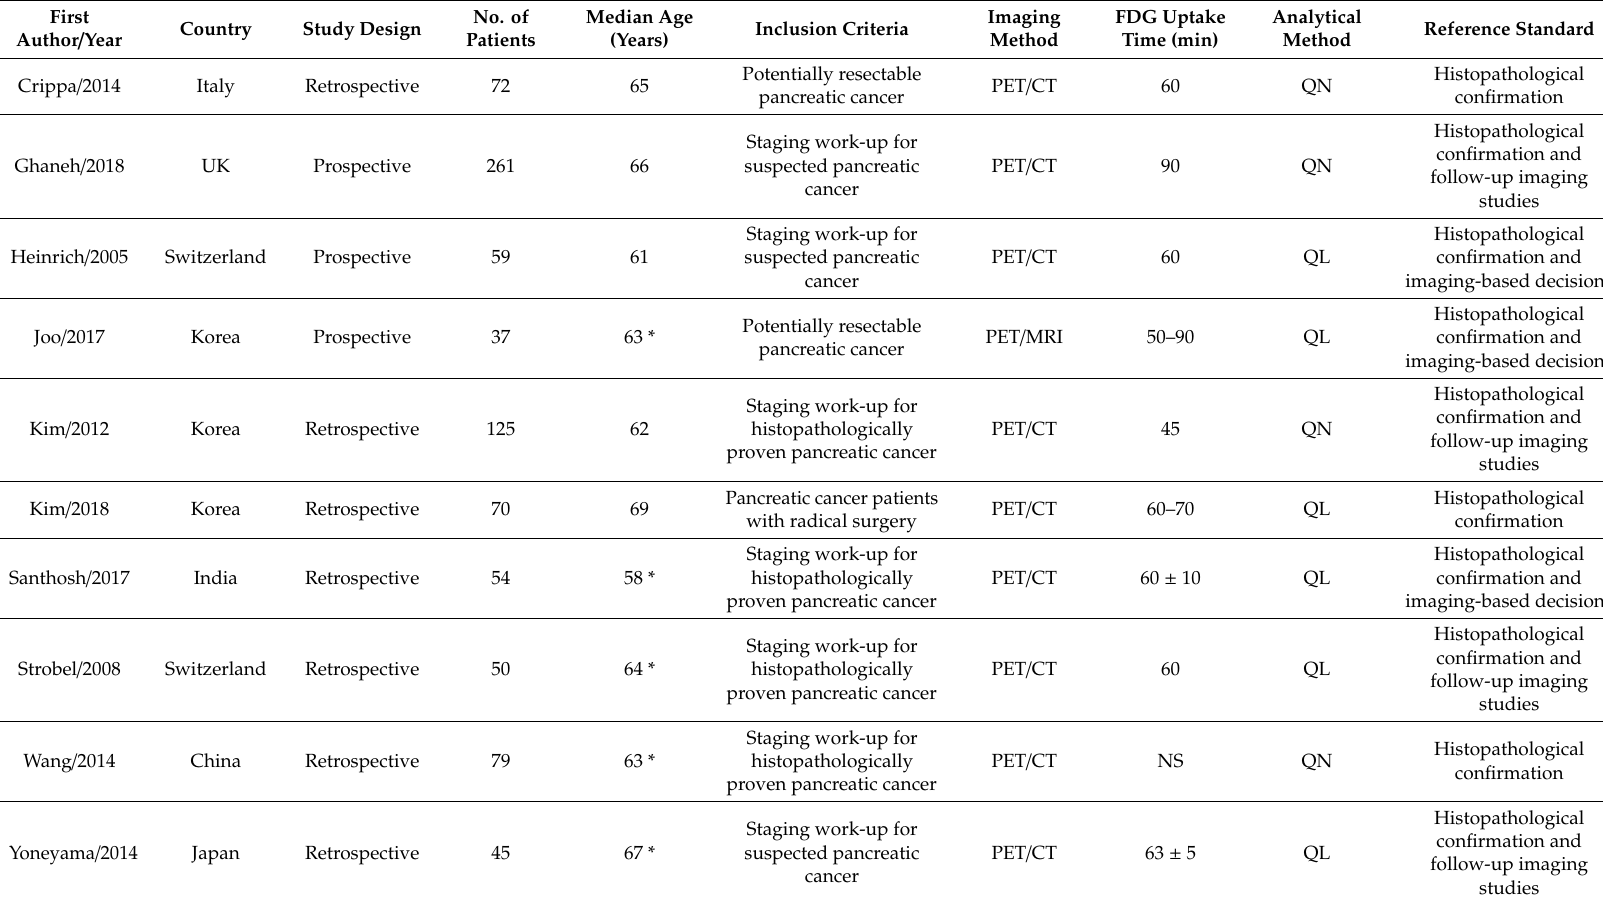
Table 1. The characteristics of included